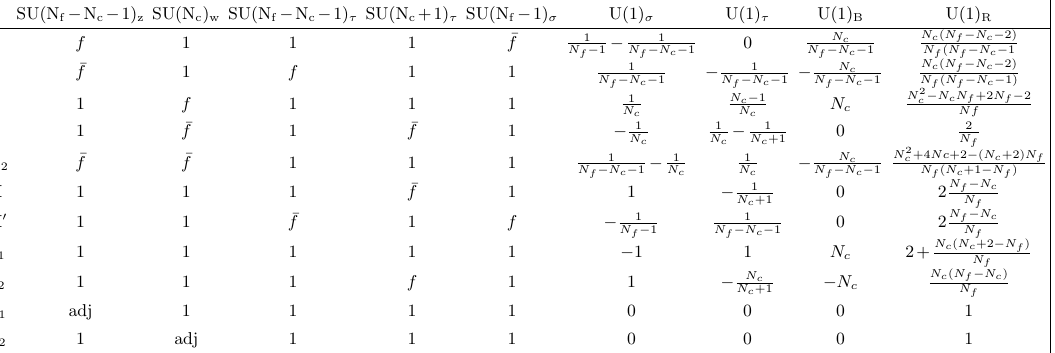
Table 6 . The matter content of the quiver gauge theory whose (cid:12)eld content corresponds to the superconformal index I quiver ; S given by eq.